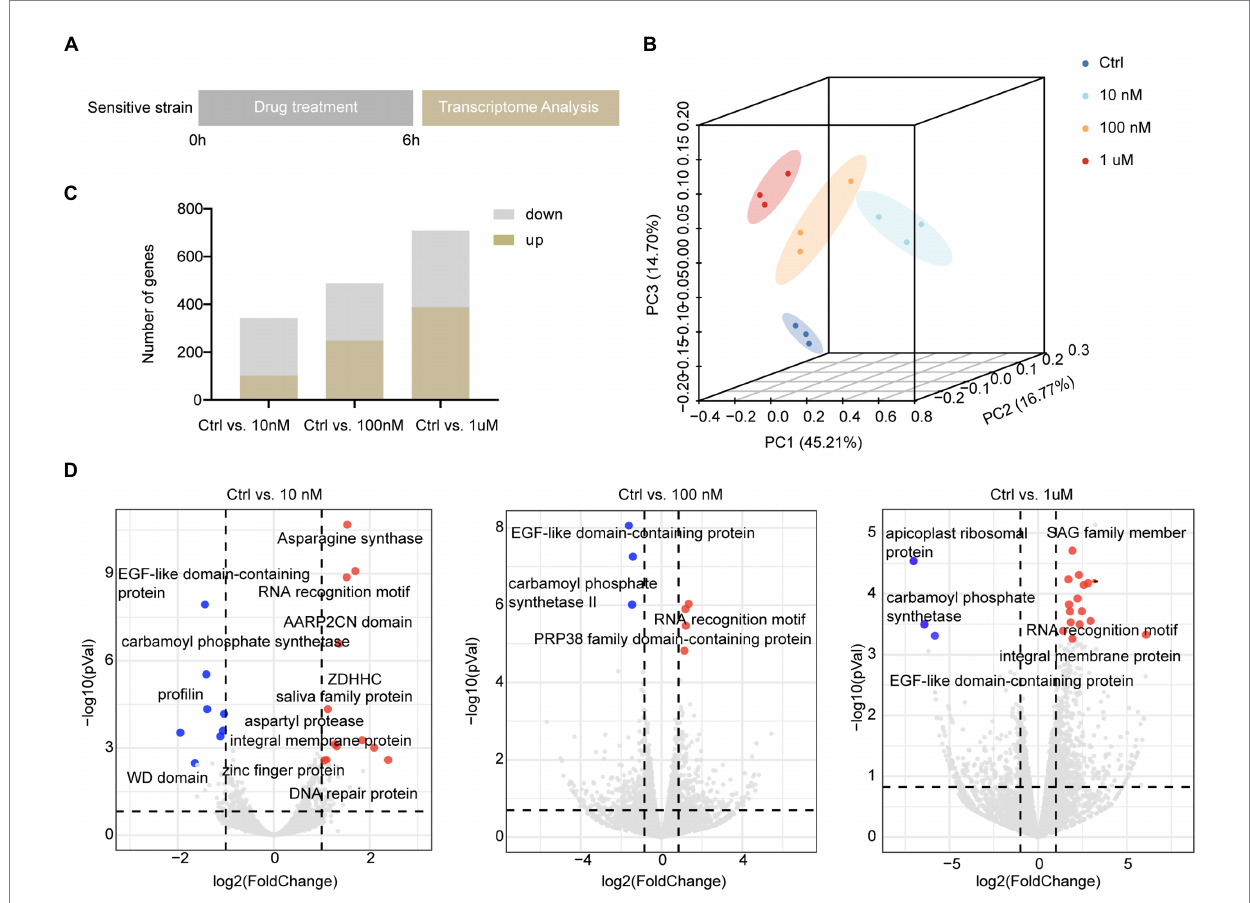
FIGURE 2 Overall description of transcriptome data among different concentrations in sensitive E. tenella . (A) Schematic illustration of the halofuginone treatment and sampling strategies. Fresh sporozoites of sensitive E. tenella strains were treated with different concentrations (0, 10, 100 nM, and 1 μ M) of halofuginone 6 h, respectively. Total RNA was then subjected to RNA-seq. (B) PCA plots for transcriptome samples labeled by different halofuginone concentrations. (C) Comparison of up-regulated and down-regulated numbers of DEGs under different concentrations, and a gene with a value of p less than 0.05 and a two-fold change was considered as a DEG. (D) Volcano plots showing the proportion of DEGs in different groups. The red dots represented up-regulated genes and the blue dots represented down-regulated genes, and the gray dots showed no